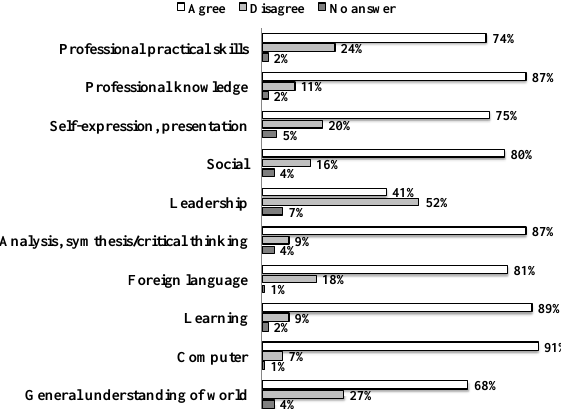
Figure 3. Employability – Technical and Non-Technical Competences that Influenced